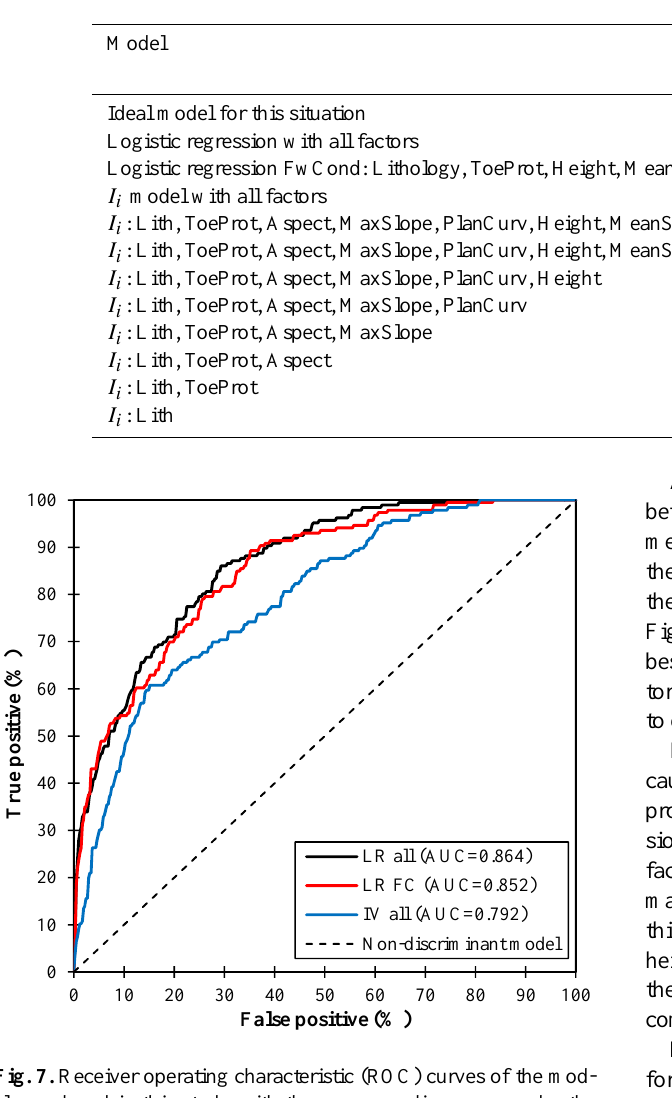
Figure 7. Receiver operating characteristic (ROC) curves of the models produced in this study with the corresponding areas under the curves (AUC). Legend: LR all – Logistic regression with all factors; LR FC – Logistic regression forward conditional; IV all – Information value with all factors.